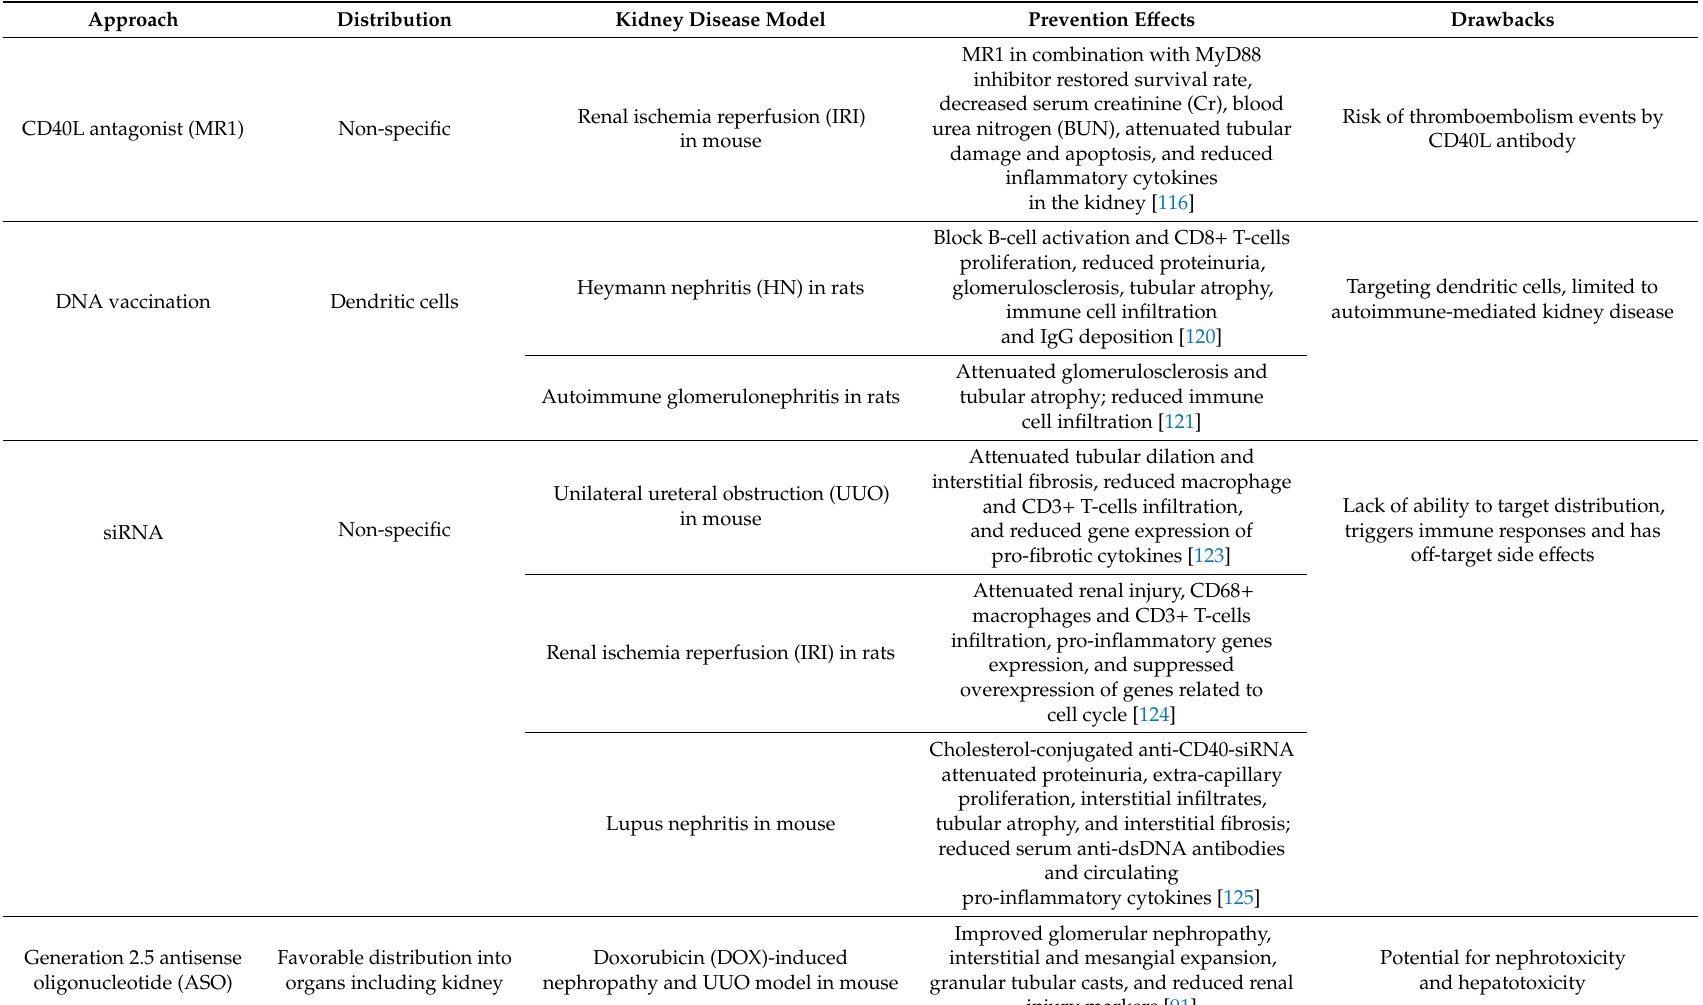
Table 2. Studies targeting CD40 in therapeutic treatments of kidney